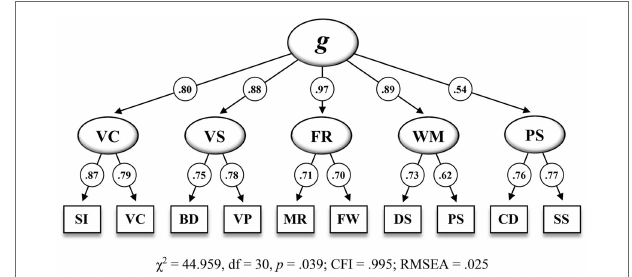
FIGURE 2 | Bifactor model with four group factors including standardized estimations for the CFA sample ( n = 823) on the 10 WISC-V primary subtests (M 6 in Table 6). SI = Similarities, VC = Vocabulary, BD = Block Design, VP = Visual Puzzles, MR = Matrix Reasoning, FW = Figure Weights, DS = Digit Span, PS = Picture Span, CD = Coding, SS = Symbol Search. g = General Intelligence, VC = Verbal Comprehension, PR = Perceptual Reasoning, WM = Working Memory. All standardized parameter estimates are significant at p <